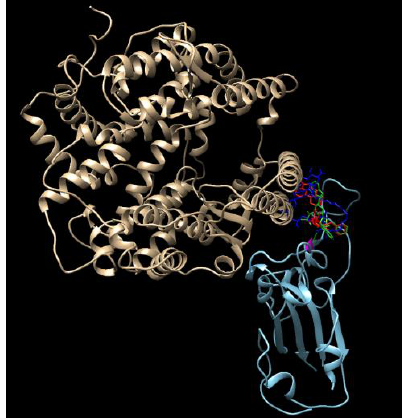
Figure 4. An overlay of the modeled structures of amphotericin, ergotamin, indinavir, and ACE-2 with the SARS-CoV-2 spike protein.